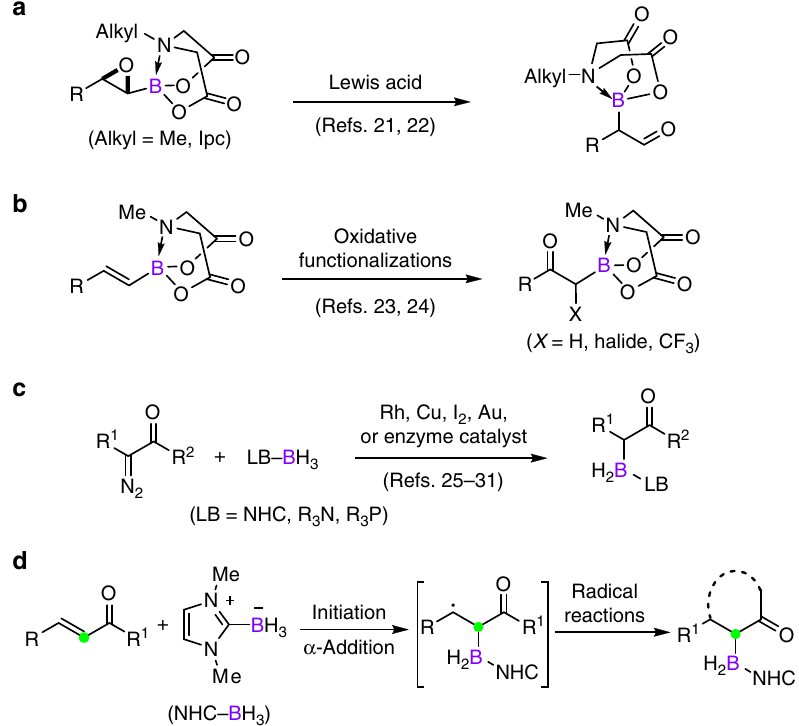
Fig. 1 Synthesis of stable α -borylcarbonyl molecules. a Lewis acid-catalyzed 1,2-boryl migration of oxiranyl boronates. b Oxidative functionalization of borylated alkenes. c B − H Insertion reactions of Lewis base-boranes and α -diazocarbonyl compounds. d This work: radical α -borylation of α , β -unsaturated carbonyl